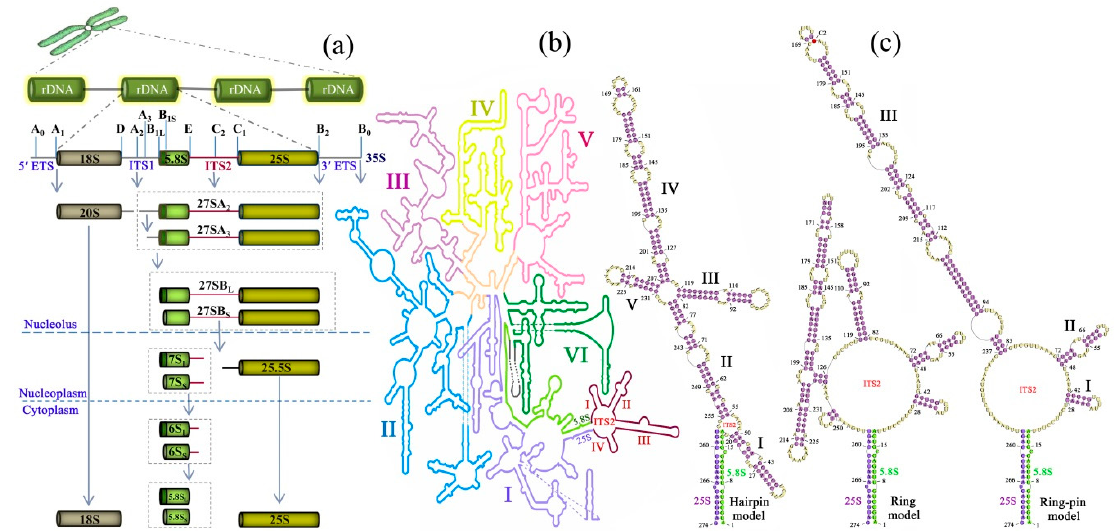
Figure 1. Overview of the ITS2 (internal transcribed spacer 2) processing and folding in the ribosome biogenesis of the yeast S. cerevisiae . ( a ) ITS2 location and processing in pre-rRNA from genome to transcriptome. ITS2 and ITS1 are intercalated in the 18S–5.8S–25S tandem arrays, separating the elements of the pre-rRNA. The endonucleolytic cleavage sites are labelled A–E on the pre-rRNA. ITS2 region is highlighted in dark red in each processing state. ( b ) ITS2 location in the secondary structure of the 5.8S / 25S pre-RNA. The ITS2 and 5.8S are displayed in dark red and bright green, respectively; the six typical domains of 25S are labelled I–VI in distinct colors. ( c ) The three proposed secondary structure models for ITS2. The C 2 cleavage site is highlighted in red in stem III of the ring-pin model. The secondary structure scheme is taken and modified from S. cerevisiae LSU (http://apollo.chemistry.gatech.edu/RibosomeGallery/).